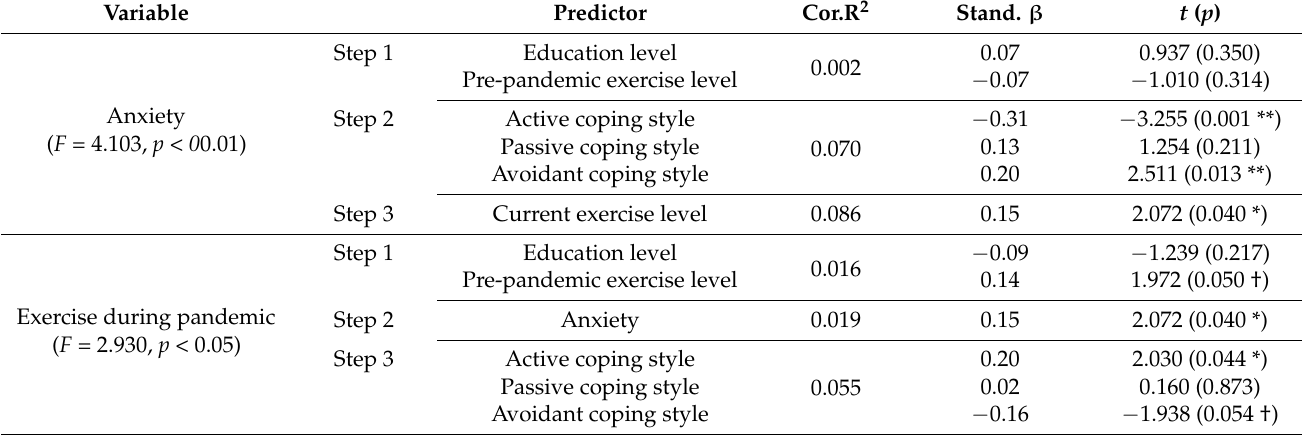
Table 4. Significant predictors of anxiety considering active, passive and avoidant coping styles and the level of exercise during the pandemic (upper panel) and of exercise practice considering active, passive and avoidant coping styles and anxiety (lower panel) (with covariates, final models). Variable Predictor Cor.R 2 Stand. β t ( p )